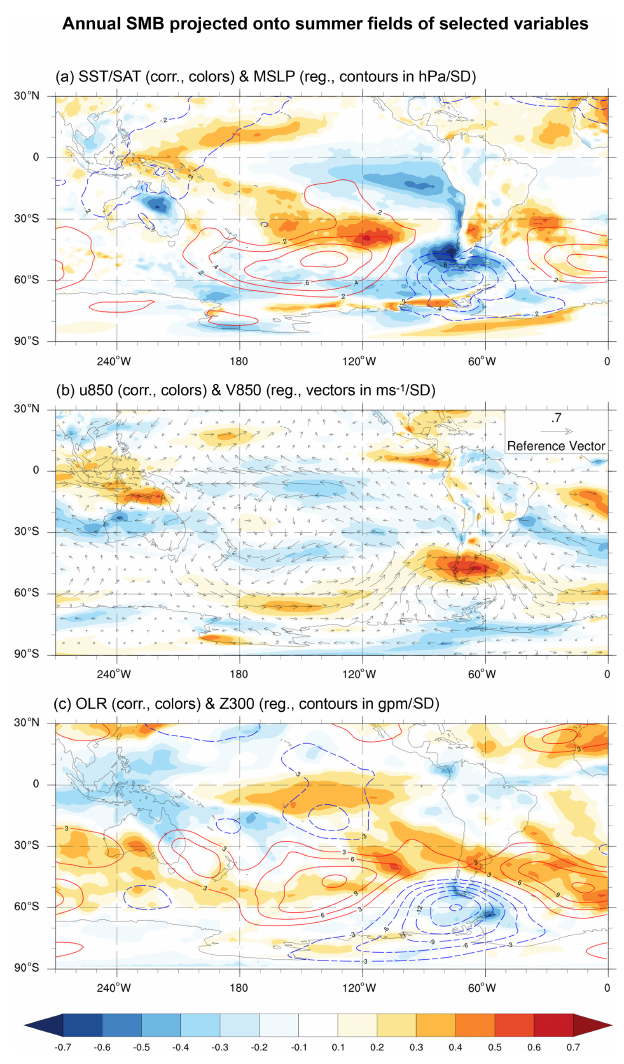
Figure 10. The same as in Fig. 8 but for the summer (October to